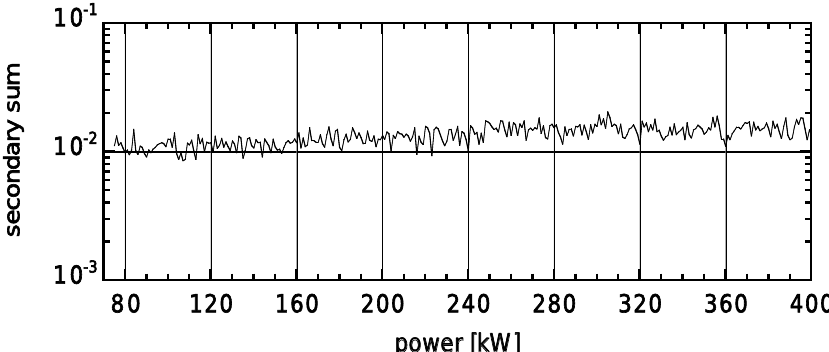
FIG. 8. Secondary multiplication summed over all launch phases in wedgeguide with dimensions a (cid:1) 21.6 cm, b (cid:1) 64.8 cm, a (cid:1) 13.2 ± , driven at 500 MHz, and initial launch radius at 29